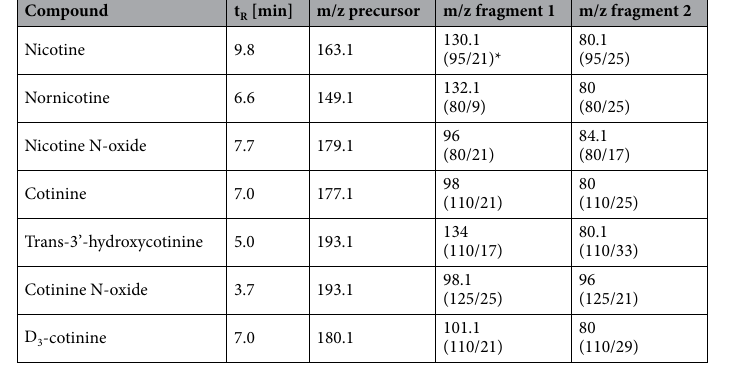
Table 1. Retention times, MRM transitions for nicotine and its metabolites. *first value in parentheses fragment voltage [V], second value collision energy [V].